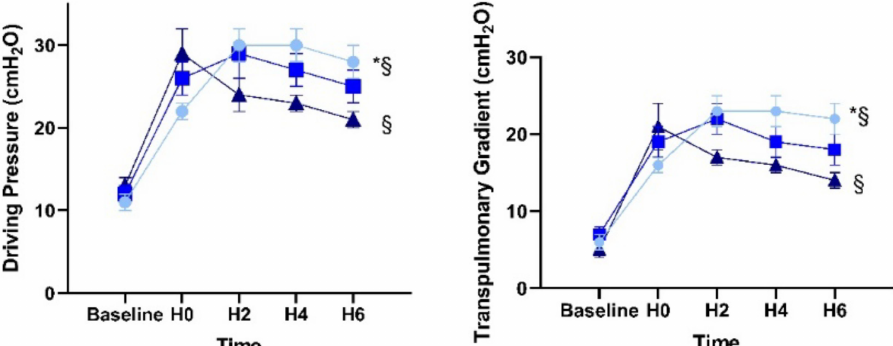
Figure 3. Alterations of driving pressure and transpulmonary gradient in response to acute lung injury and intra-abdominal pressure of 10 mmHg over 6 h of mechanical ventilation. • = group A with PEEP: 5 cmH 2 O, (cid:4) = group B with PEEP: 10 cmH 2 O, (cid:78) = group C with PEEP: 15 cmH 2 O. * = p < 0.05 H0 vs. H6 § = p < 0.05 group A vs. group C. The CI was lower in groups B and C between H0 and H6 (4.4 ± 0.3 vs. 3.9 ± 0.2; p = 0.038 and 5.2 ± 0.4 vs. 3.7 ± 0.1; p = 0.018). Group C received more fluids (mL) than group A (7125 ± 573 vs. 4900 ± 433; p = 0.030). Despite alterations in the CI, the P/F ratio increased in all groups after 6